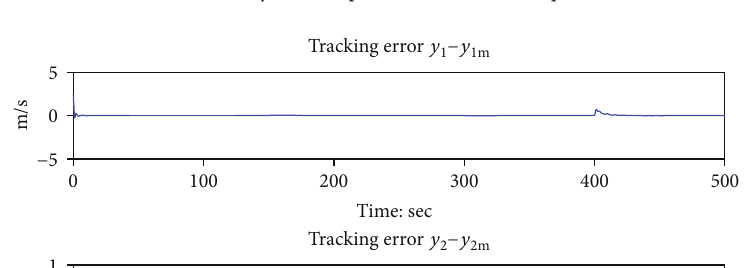
Figure 1: System outputs and reference outputs.